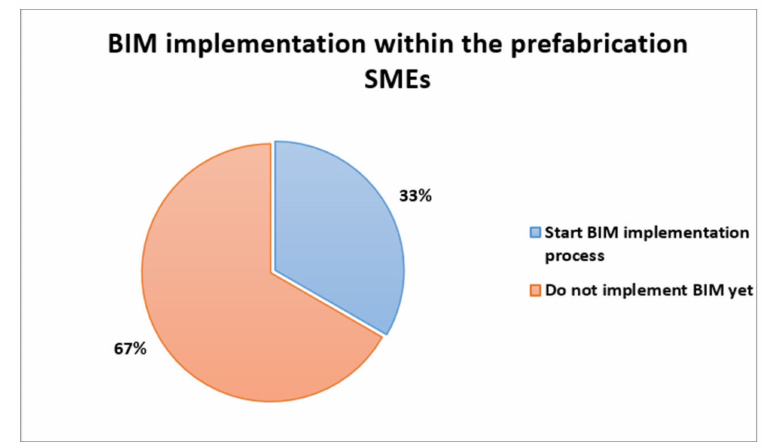
Figure A3. BIM implementation within prefabrication SMEs.